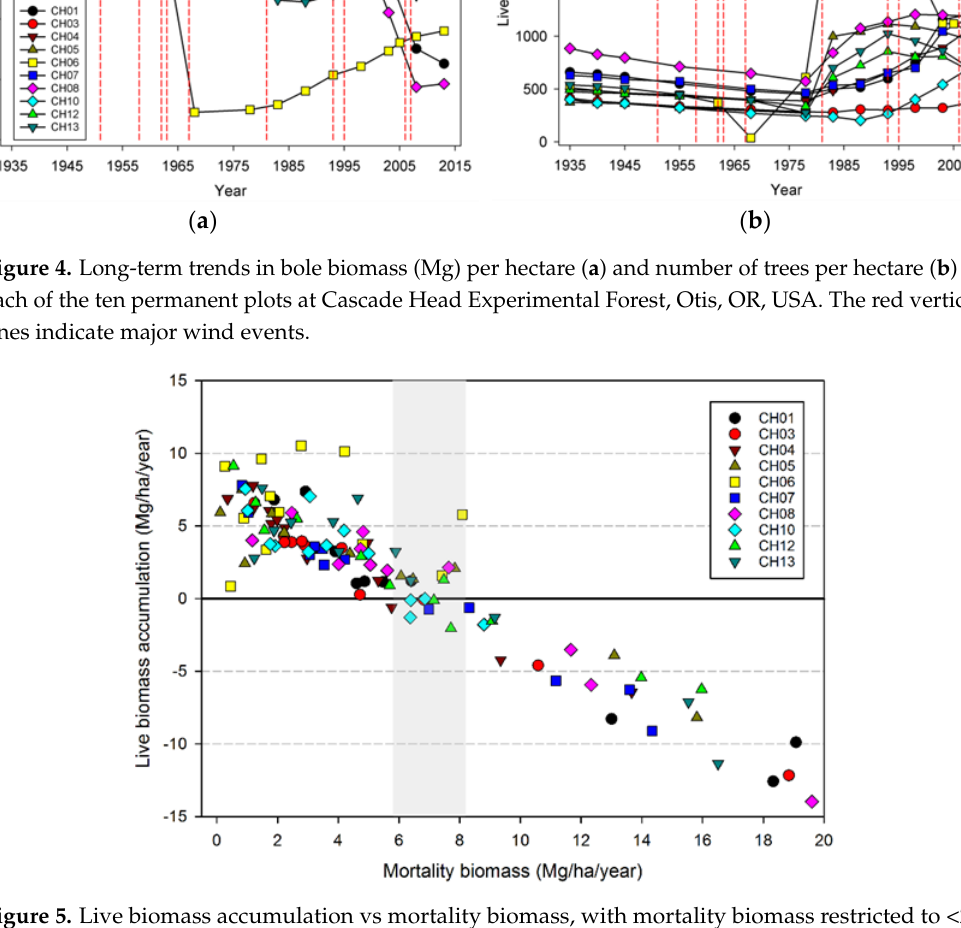
Figure 5. Live biomass accumulation vs mortality biomass, with mortality biomass restricted to <20 Mg/ha/year (outliers go to ~90 Mg/ha/year; see Figure S1 for full range of values). The gray bar indicates uncertainty in the value of mortality that leads to a negative live biomass accumulation (5.8–8.2 Mg/ha/year).